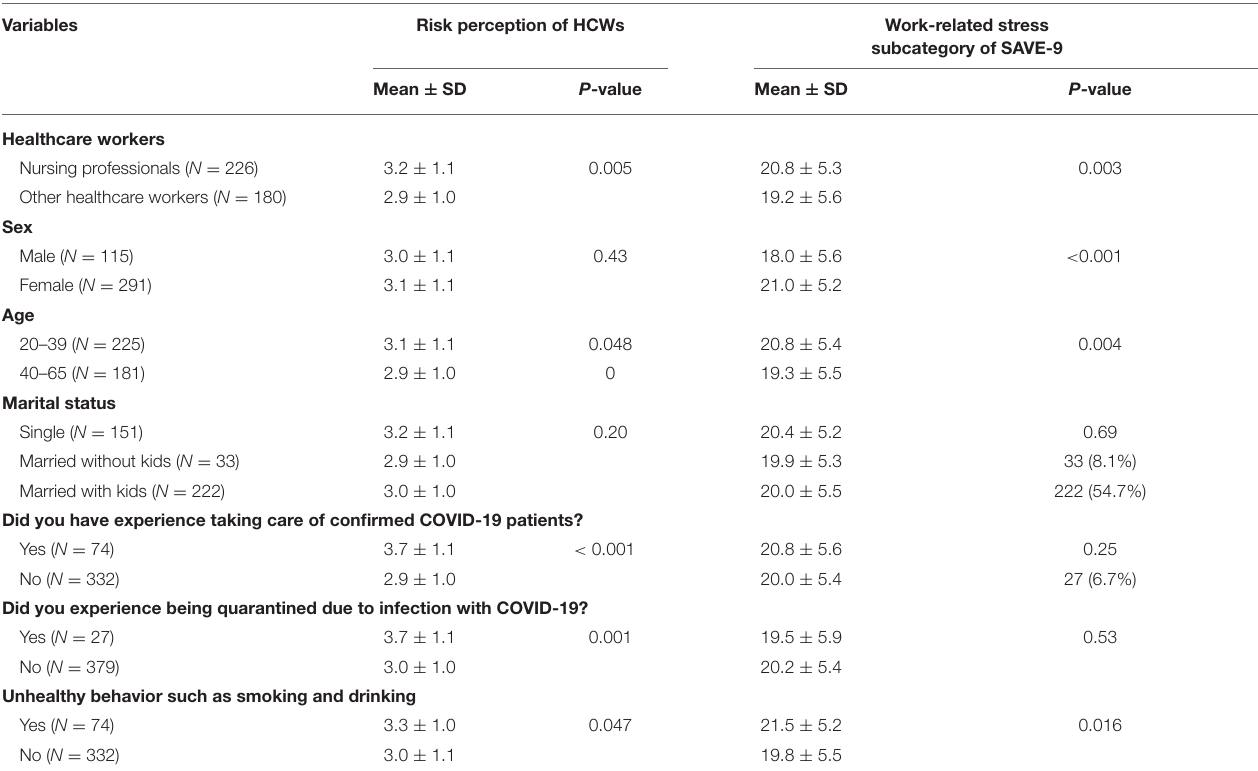
TABLE 2 | Healthcare workers’ risk perception and anxiety response to the viral epidemic ( N = 406). Variables